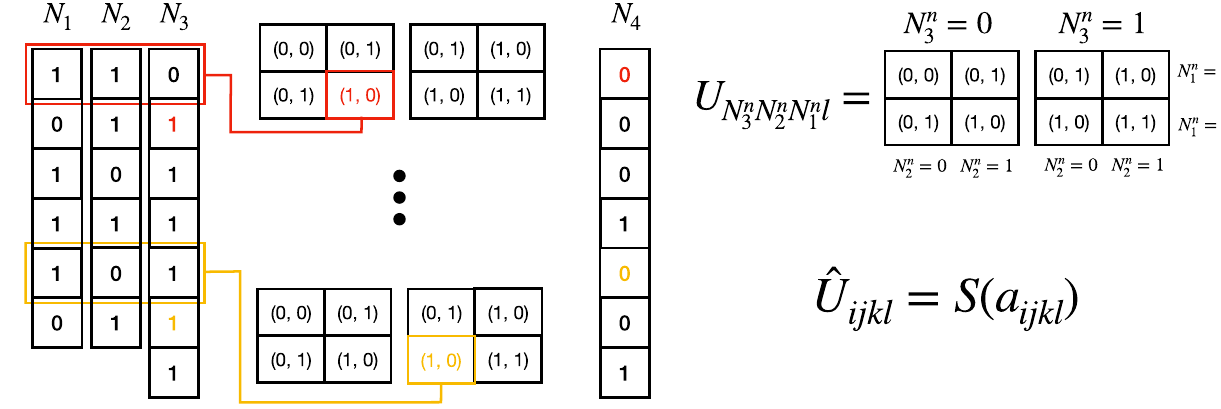
Figure 1. Addition of two binary numbers. U ijkl can be understood as a convolutional operator (different from the classical convolutional filters). It is applied to the input ( N 1 , N 2 ) line by line. Line nth of the input has values N n 3 , N n 2 and N n 1 that correspond to indices ijk respectively. The chosen array U N n 1 n output N n + 3 and N 4 . N 4 corresponds to the result of N 1 + N 2 , in this case the operator used in our NN, with parameters a ijkl that are learned through training. ˆ U ijkl acts on N n 3 , N n 2 and N n 1 analogously to U ijkl , although in this case N n 3 can be a real number different from 0 or 1, in that case the output is a combination of both options, weighted with N n 3 . See the main text for more